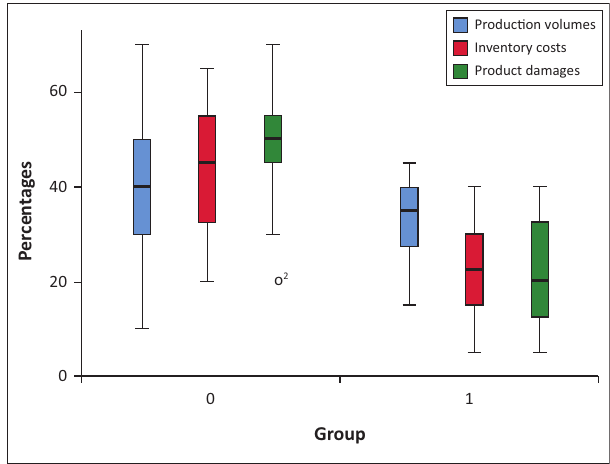
Inventory costs Product